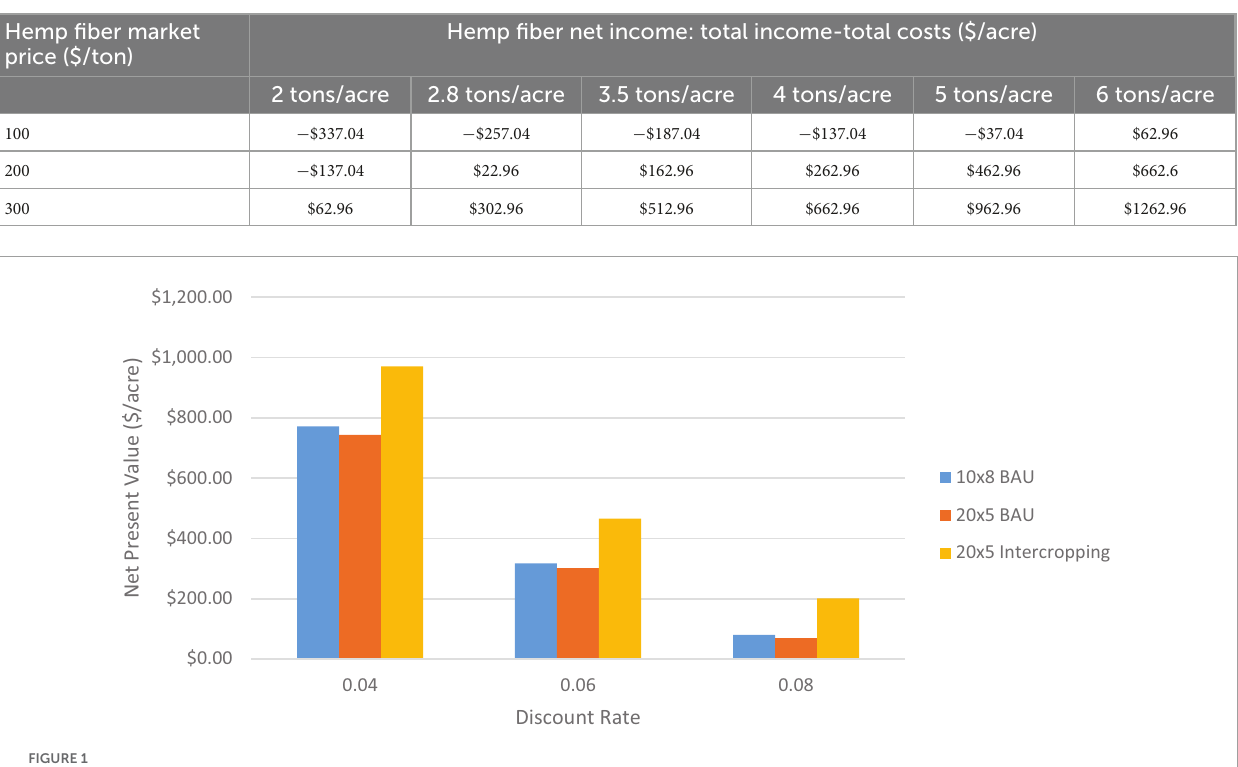
FIGURE1 Net present values (NPVs) from monoculture loblolly and intercropping scenarios under the discount rate of 4%, 6%, and 8%.